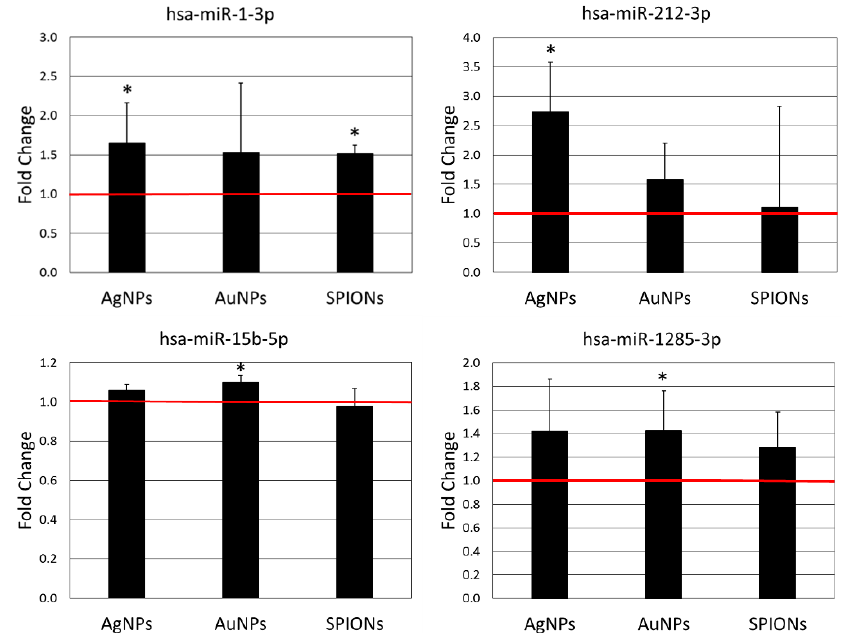
Figure 3. Expression of miRNAs up-regulated by AgNPs (10 µg/mL), AuNPs (10 µg/mL) or SPIONs (5 µg/mL) treatment for 6 h. Data are expressed as the mean ± standard deviation from three independent experiments. The red line shows the expression level in the control group. Asterisks denote a statistically significant difference versus the control group.